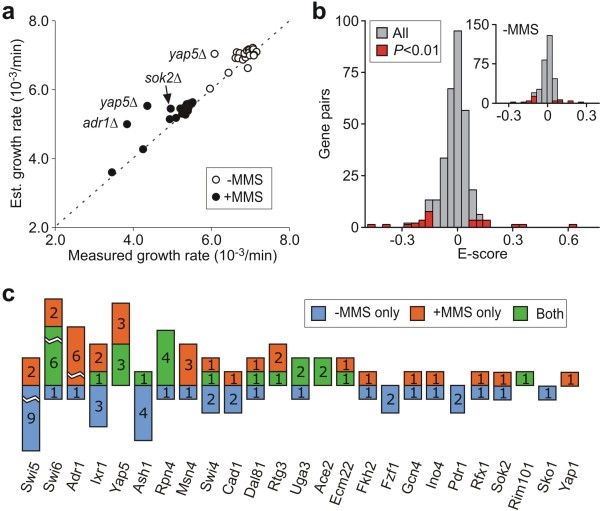
Fitness-based epistatic analysis. (a) Correlation between measured and estimated single mutant growth rates. (b) Histograms of fitness-based epistasis scores (F-Score) calculated for all TF-TF pairs (grey) and those associated with high confidence genetic interactions (red) in the presence of MMS. Insert displays the corresponding histograms in the absence of MMS. (c) The number of epistatic interactions identified for each TF, categorized according to the environment where the interaction was identified. 18 interactions are identified exclusively in absence of MMS, 15 are identified only in the presence of MMS and 12 are identified in both environments.